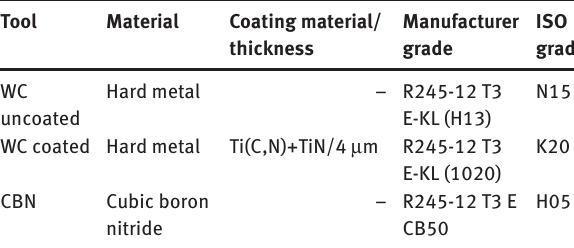
Table 2: Cutting tools and their